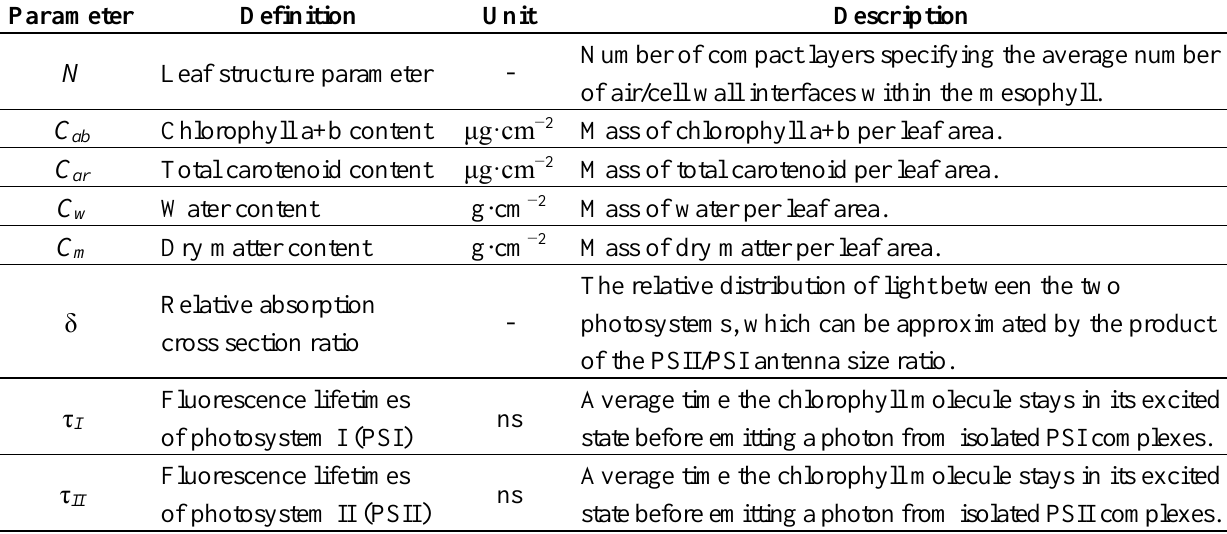
Table 1. The definitions, units, and descriptions of the eight input parameters of the FluorMODleaf model